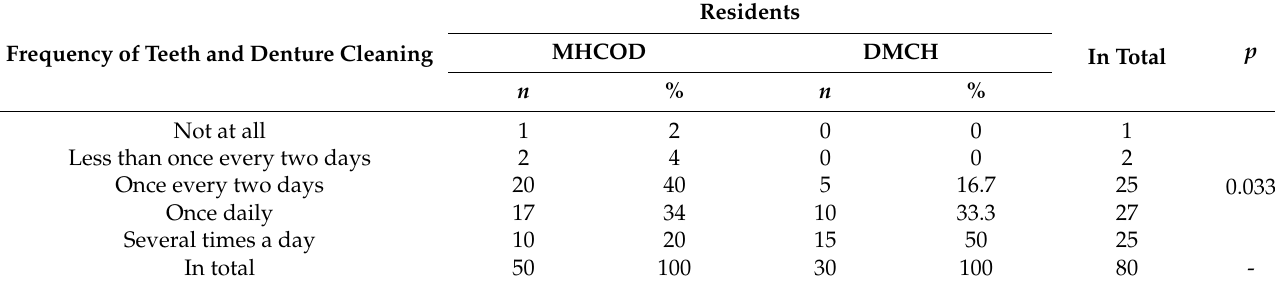
Table 7. Frequency of teeth and denture cleaning in study groups.